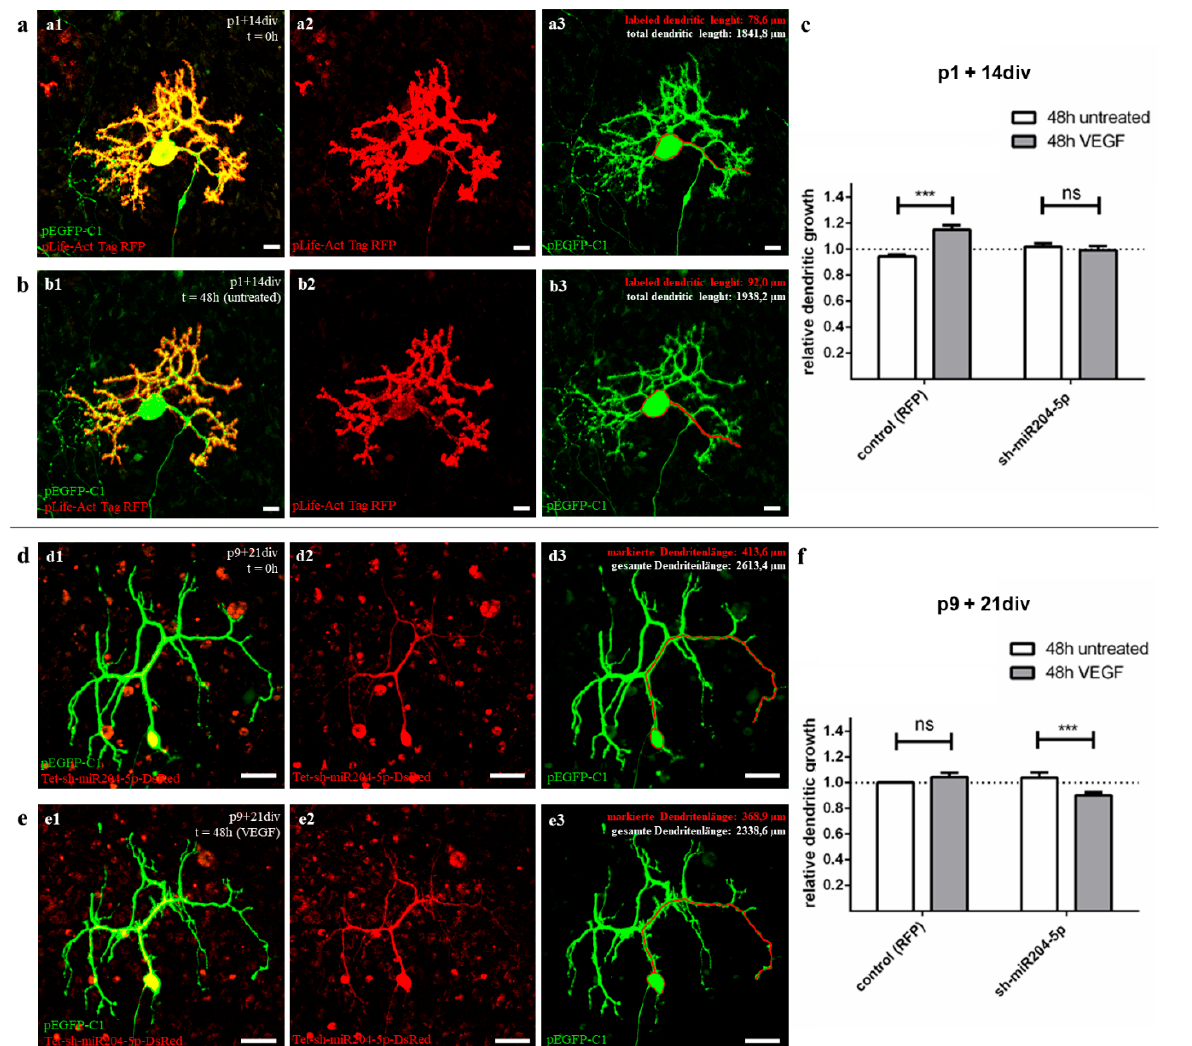
Figure 5. Morphometric analysis of miR204-5p effects on VEGF controlled dendritic growth in juvenile and mature PC. ( a , b ) Exemplary presentation of dendritic length analysis of PC at the age of p1 + 14div (group 2) injected with pEGFRP-C1 (green) and pLife-Act Tag RFP (red) before ( a ) and after 48 h untreated incubation ( b ). ( d , e ) Example of a PC at age p9 + 21div, injected with pEGFRP-C1 (green) and pLKO-miR204-DsRed (red) before ( d ) and after 48 h incubation with 0.1 ng/ µ L VEGF ( e ). The total dendritic length was measured for each cell that showed both sufficient red and green signal (one dendrite is shown in red for each cell before and after treatment as an example), and relative dendritic growth (RDG) was calculated. (c f) Effects of miR204-5p on VEGF-controlled dendritic growth in juvenile ( c ) and mature PC ( f ). Changes in dendritic growth are given in relative ratio (RDG = (dendritic length at t = 0 h)/(dendritic length at t = 48 h)); data are given as mean values ± SEM. Cells injected with pLife-Act Tag RFP only are defined as controls representing the natural VEGF reaction compared to the sh-miR204-5p injected PC. Significant differences are indicated by *** p < 0.0001, ns p > 0.05; n ≥ 9 (each bar). Scale bars: ( a , b ) 20 µm ( d , e ) 50 µm.